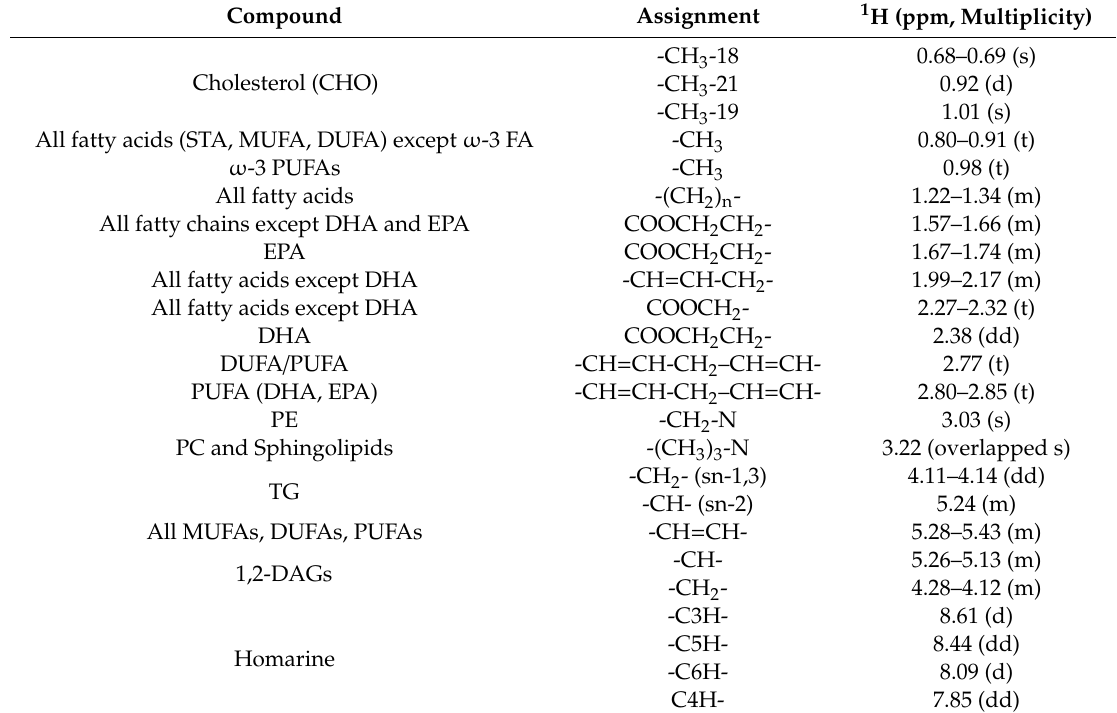
Figure 1. Typical 1 H NMR spectrum obtained at 600 MHz of CD 3 OD/CDCl 3 lipid extract of R. pulmo . ( a ) Full spectrum of three body compartments, and ( b ) expansion spectrum at high frequency regions obtained only for the female gonads extracts. Table 1. Chemical shift and assignments of main peaks in the 1 H NMR spectra of CD 3 OD/CDCl 3 extracts of the three different body compartments of R. pulmo (d: doublet; dd: double of doublets; t: triplet; m: multiplet; s: singlet).